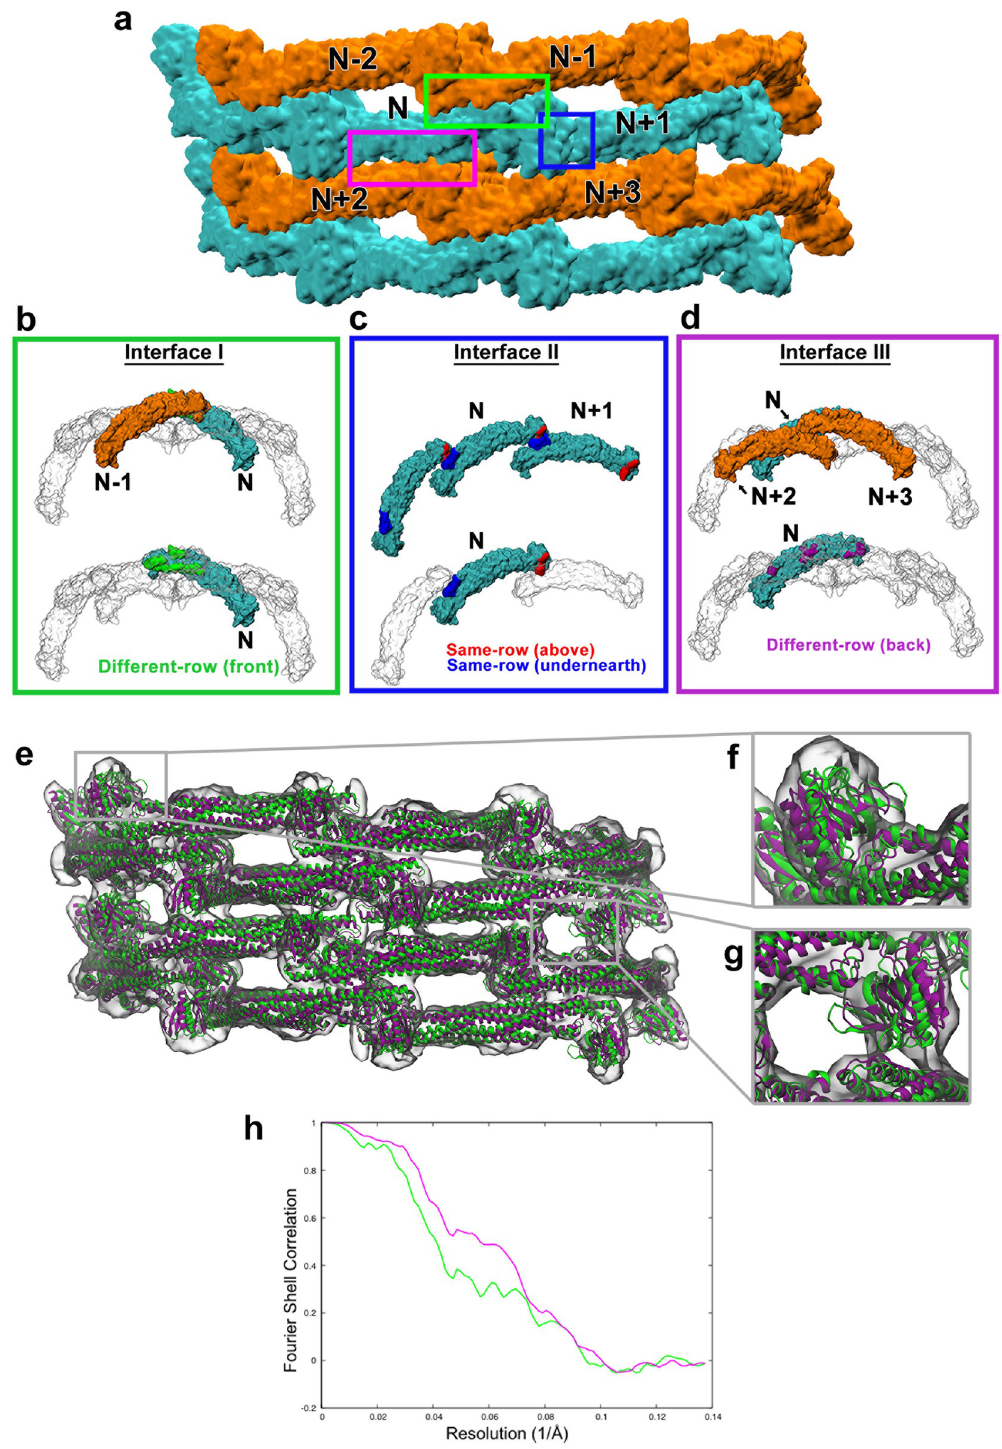
Fig 1. Configuration of a partial ACAP1 BAR-PH protein lattice. ( a ) Surface diagram of the ACAP1 BAR-PH protein lattice in the class 1 MDFF simulation with dimers labelled. Three interaction interfaces are enclosed with three boxes of colours: green for the front interactions (Interface I), blue for same-row interactions (Interface II), and magenta for the back interactions (Interface III). ( b-d ) Surface diagram of ACAP1 BAR-PH dimers shown in cyan, orange or transparent in the upper panels. Cyan and orange colours indicate dimers in different rows. In the lower panels, some dimers were made transparent to